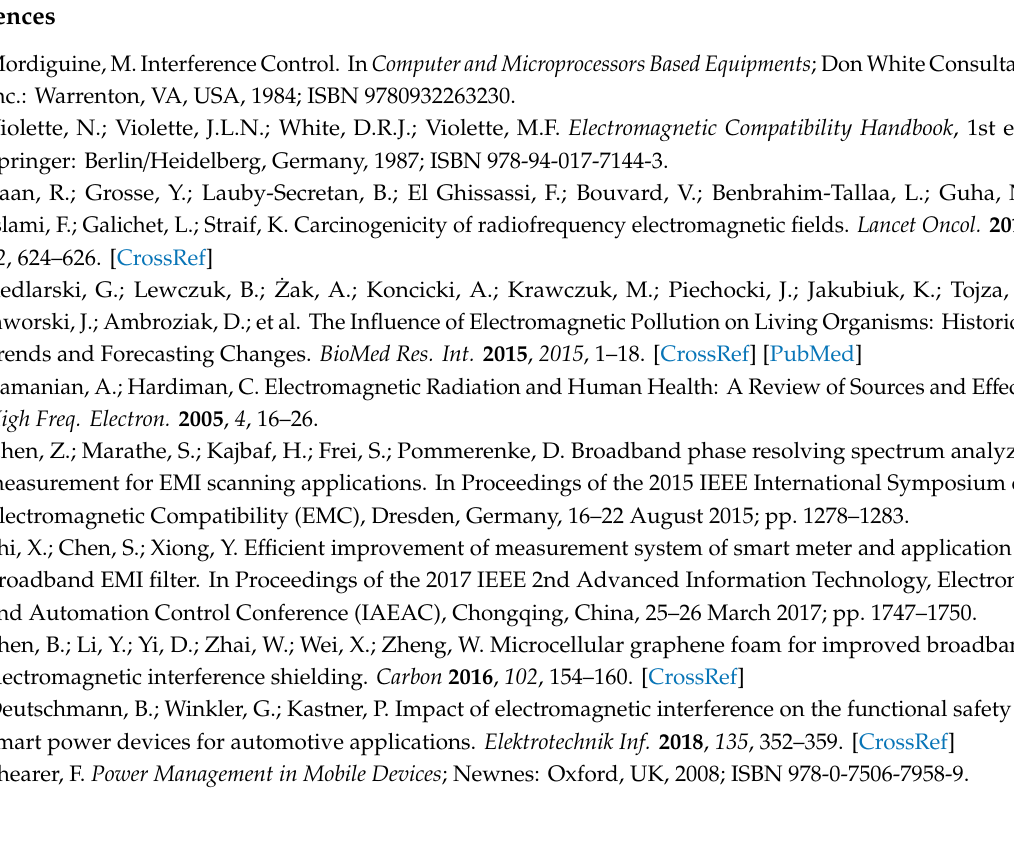
Figure S1: SEM images of the nylon 66 and / or the deposited Ag layers in (a) E-0, (b) N-0, and (c) N-50. The scale bars indicate 2 µ m. Figure S2: Pore size distributions of the ethanol-treated and then hot-pressed mats without (gray) and with (red) the Ag-deposition. The average pore diameter of the former and latter is 100.0 and 58.6 nm, respectively. The portion of pores with smaller size increases during the metal deposition process. Figure S3: DSC measurement results of the electrospun nylon 66 mats and film. (a) DSC thermographs of the electrospun mats produced from as-spun, ethanol-treated, and ethanol-treated mats hot-pressed at 40, 70, 120, 160, and 200 ◦ C. (b) Measured crystallinity using DSC for ethanol-treated / hot-pressed electrospun mat (black square) and ethanol-treated / hot-pressed non-porous film (red circle) as a function of the hot-pressing temperature. The crystallinity of non-porous film was hot-pressed only at 160 ◦ C. The measurements were performed with a heating rate of 10 ◦ C / min and a nitrogen purge gas. Figure S4: Numerically calculated SE A / SE T of a multi-layered structure with applied electrical conductivity of Ag layers in N-50 (black continuous line) and E-50 (red continuous line) on the X- and K u -bands. Figure S5: Mesh configurations for numerical calculation using COMSOL. (a) “Normal mesh” type was applied as a waveguide, including a sample at the center of the waveguide. (b) Enlarged mesh configuration in the central region of the waveguide. Figure S6: Schematic cross-sectional diagrams of the i th layer in a multi-layer structure and N-50. (a) The i th interface refers to the left interface of the i th layer, and the E i + and E i − are forward (ˆ z ) and backward ( − ˆ z ) electric fields on the left side of the i th interface. Moreover, q i and p i refer to the reflection coe ffi cient and the transmission coe ffi cient at the i th interface. (b) Cross-section schematics of N-50. The intrinsic impedance, propagation constant, and thickness of the i th layer are expressed as η i , γ i , and t i , respectively when i is 0 to 10. Figure S7: Porosity of as-spun, hot-pressed electrospun mat, and E-50. Notably, the thickness of E-50 was enough to be measured, which made the error bar of E-50